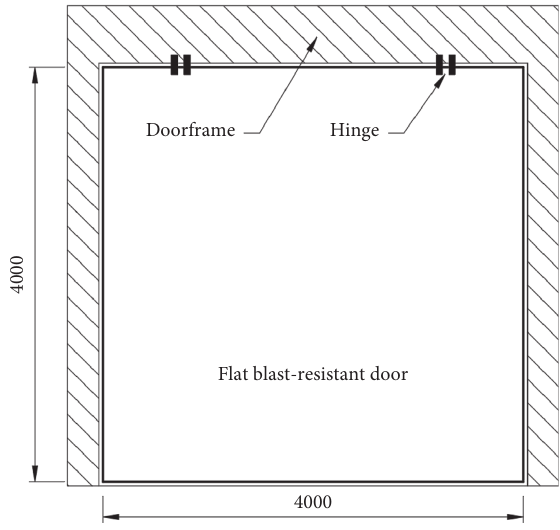
Figure 3: Flat blast-resistant door (FBD; unit: Figure 5. The projection dimensions of the blast-resistant doors studied in this paper are all 4,000 mm × 4,000 mm, and their specifications are shown in Table 3.